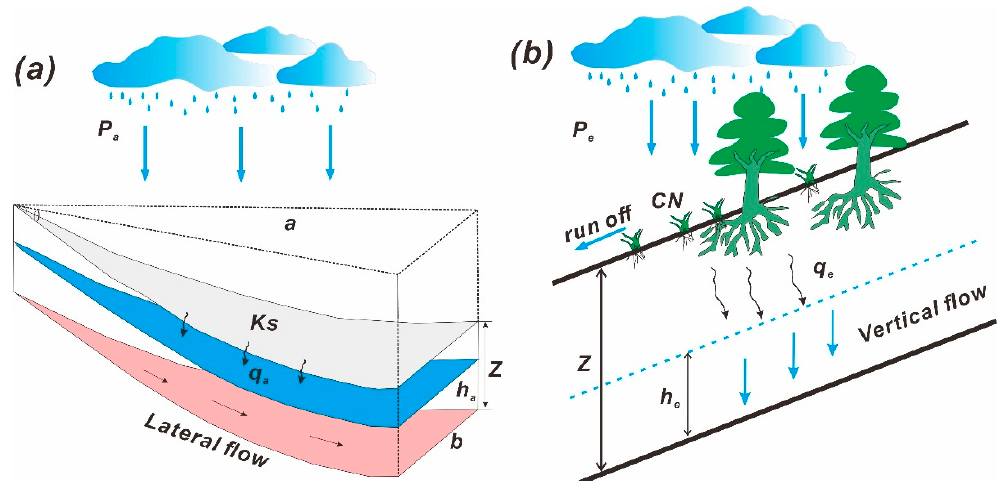
Figure 10. Hydrological models incorporated in FSLAM: ( a ) Incorporation of antecedent rainfall (Pa) by the lateral flow approach. ( b ) Incorporation of event-specific rainfall (Pe) by the vertical flow approach. The model graph is revised from the work of Medina, Hürlimann, Guo, Lloret, and Vaunat [46].